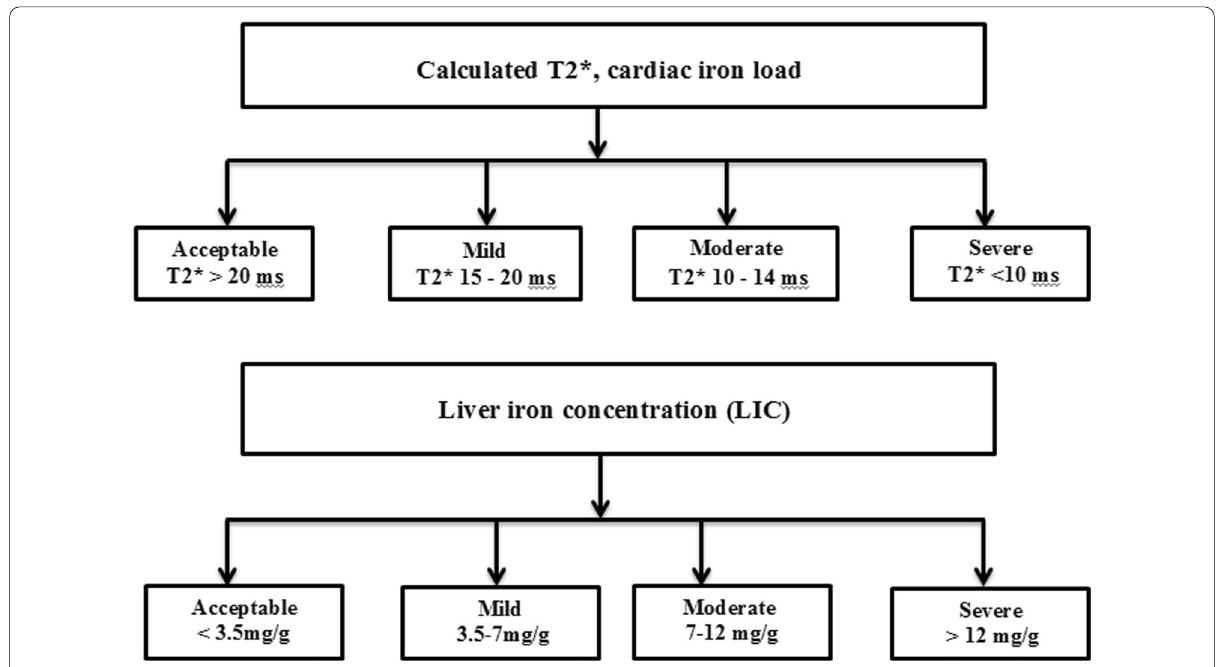
Fig. 1 Calculated T2*, cardiac iron load and liver iron concentration (LIC) in transfusion-dependent beta-thalassemia major